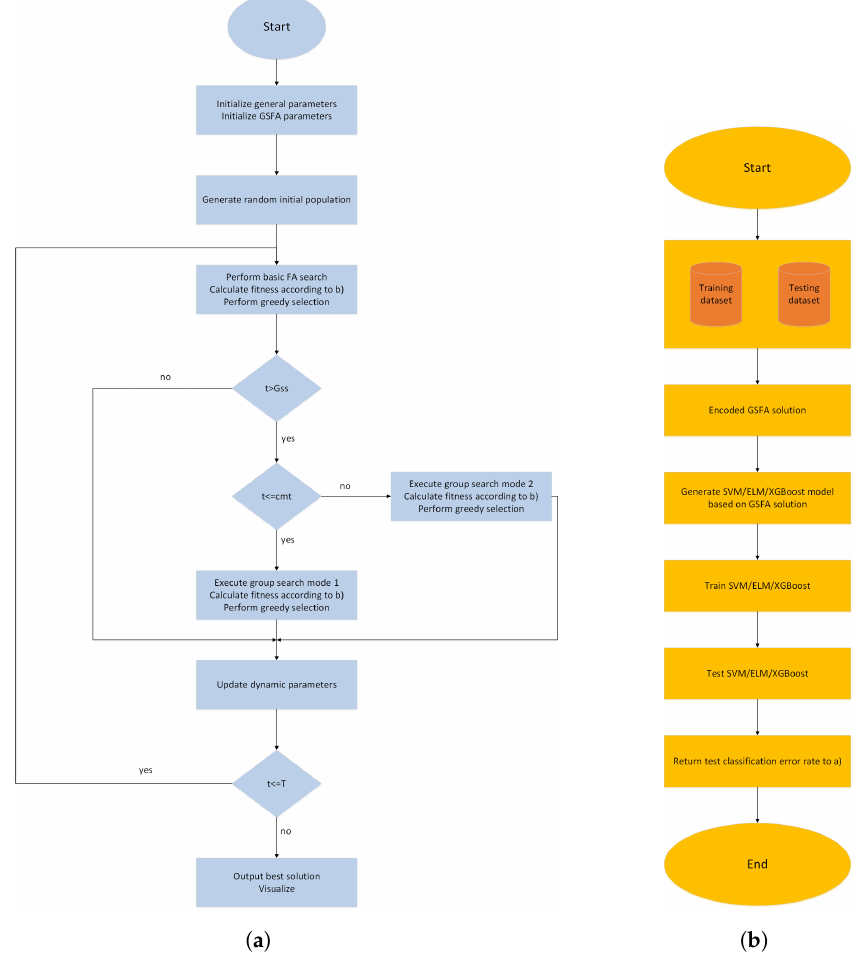
Figure 3. Flow-chart diagram of proposed methodology in this study. ( a ) The SVM/ELM/XGBoost GSFA flow chart. ( b ) Fitness